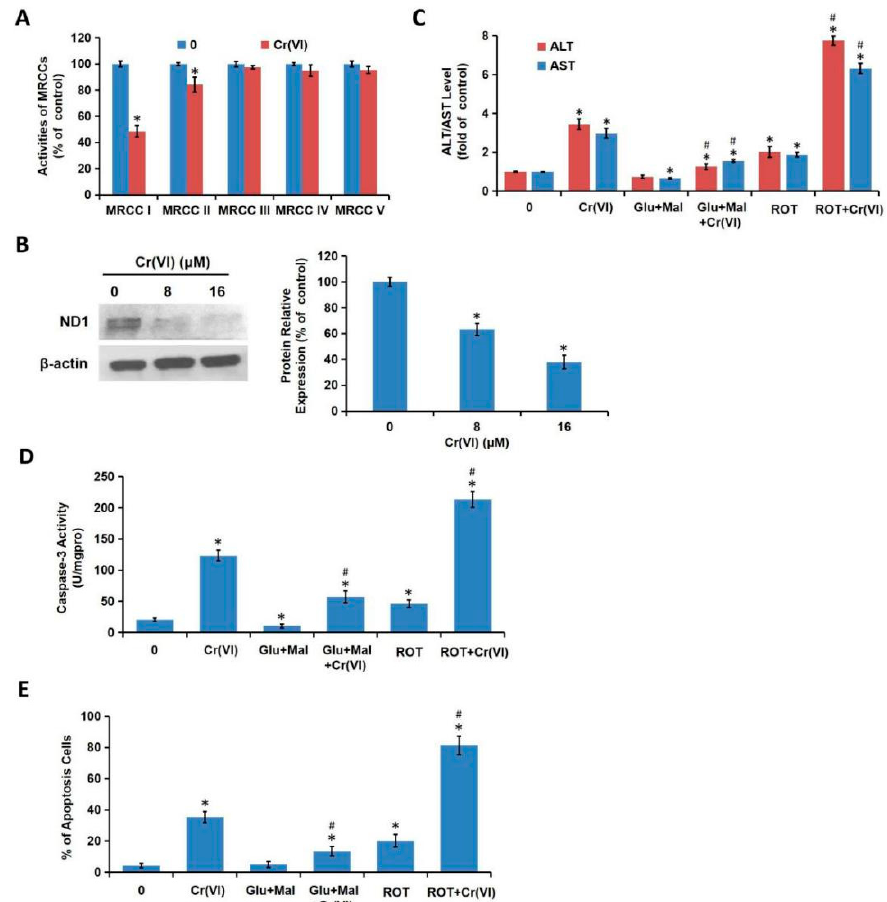
Figure 3. Cr(VI) targeted MRCC I to induce cytotoxicity. ( A ) L02 hepatocytes were treated with different concentrations of Cr(VI) (0, 8, 16 µM) for 24 h. The activities of MRCC I-V were determined spectrophotometrically using the commercial kits. ( B ) The protein expression of ND1 was